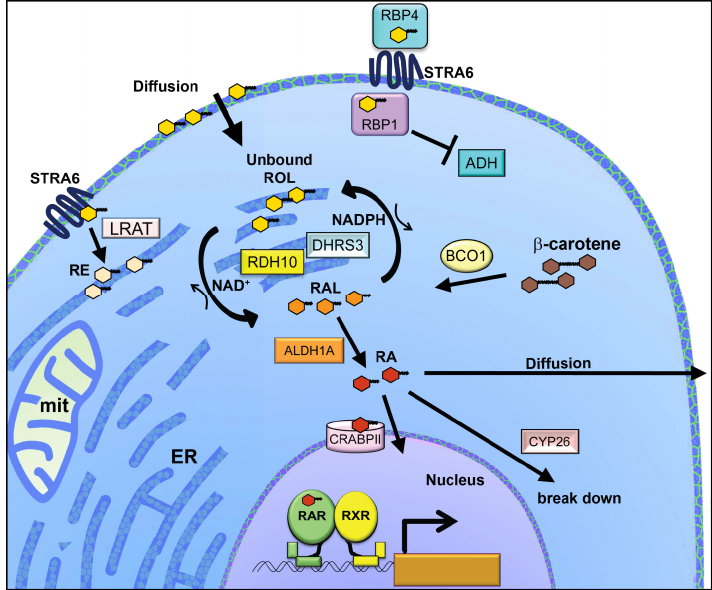
Figure 4. RA production in embryo cells is regulated by enzymatic metabolism and catabolism. Embryo cells obtain retinoids from maternal sources via circulation. In the blood serum the hydrophobic ROL is bound by RBP4. ROL enters embryo cells predominantly through membrane diffusion. ROL can also be transported into cells via RBP4 delivery to the membrane transporter STRA6. Inside the cell hydrophobic ROL can be associated with a membrane compartment, where it can exist as free retinoid. Hydrophobic ROL can be present in the aqueous cytosol if it is bound by RBP1. ADH enzymes do not participate in metabolism of ROL in embryo tissues under normal conditions because the cytoplasmic enzymes cannot act on RBP1-bound ROL. RDH10, a membrane bound SDR, acts on free ROL, possibly from a membrane pool, or alternatively, delivered from RBP1. A related membrane SDR, DHRS3 catalyzes the reduction of RAL to ROL. RDH10 and DHRS3 are oxidoreductases